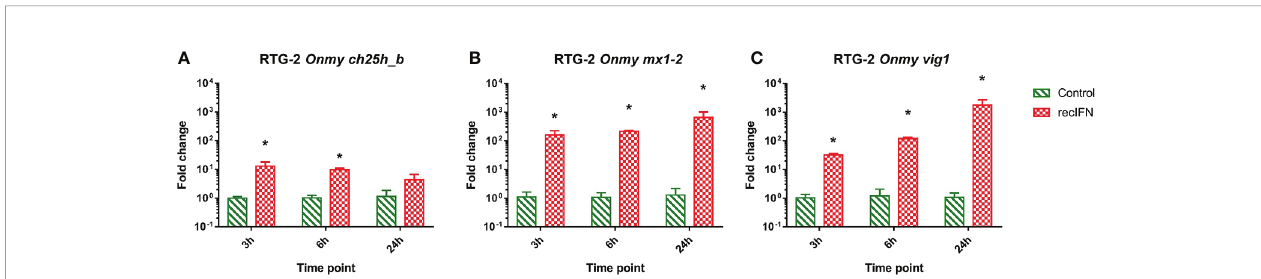
FIGURE 7 | Effect of the incubation of rainbow trout gonad (RTG-2) cells with rainbow trout recombinant IFNa1 (recIFN) on the transcription of mRNA encoding the enzyme involved in the generation of oxysterol ch25h_b (A) , the IFN stimulated gene vig1 (B) , the IFN stimulated gene mx1-2 (C) . Data presented as a bar indicating mean fold change (+SD) from n = 3 replicates. * indicates a statistically signi fi cant difference at p<0.05 between control and the recombinant IFN treatment. Analysis was performed with two-way ANOVA with treatments and time points as factors. The ANOVA was followed by subsequent pairwise multiple comparisons using the Holm-Sidak